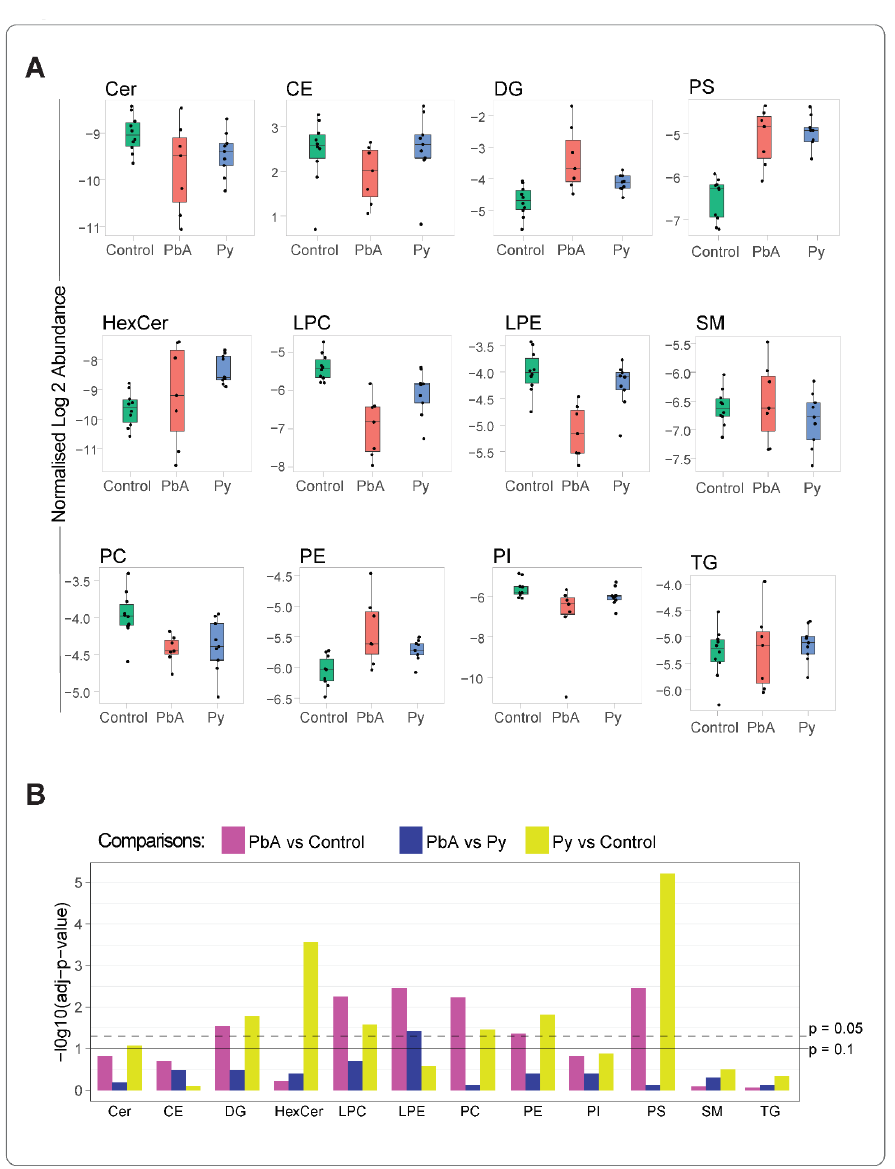
Figure 2. Altered lipid class levels in MV (18k PFP) from the three groups of mice. The mean value of the concentrations (pmol/uL) of lipid ions belonging to a lipid class was estimated. The lipid ion concentration was calculated by normalising to the respective internal standards ( A ) Boxplots comp